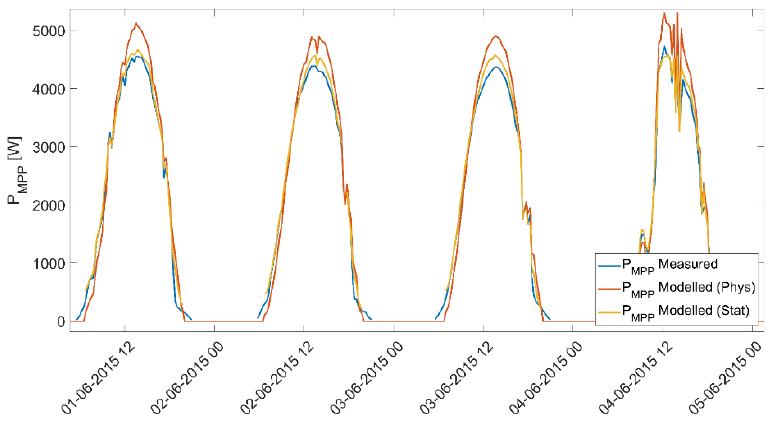
Figure 7. Application of the physical and statistical models for inverter 1U01-T2: measured vs. modeled power.